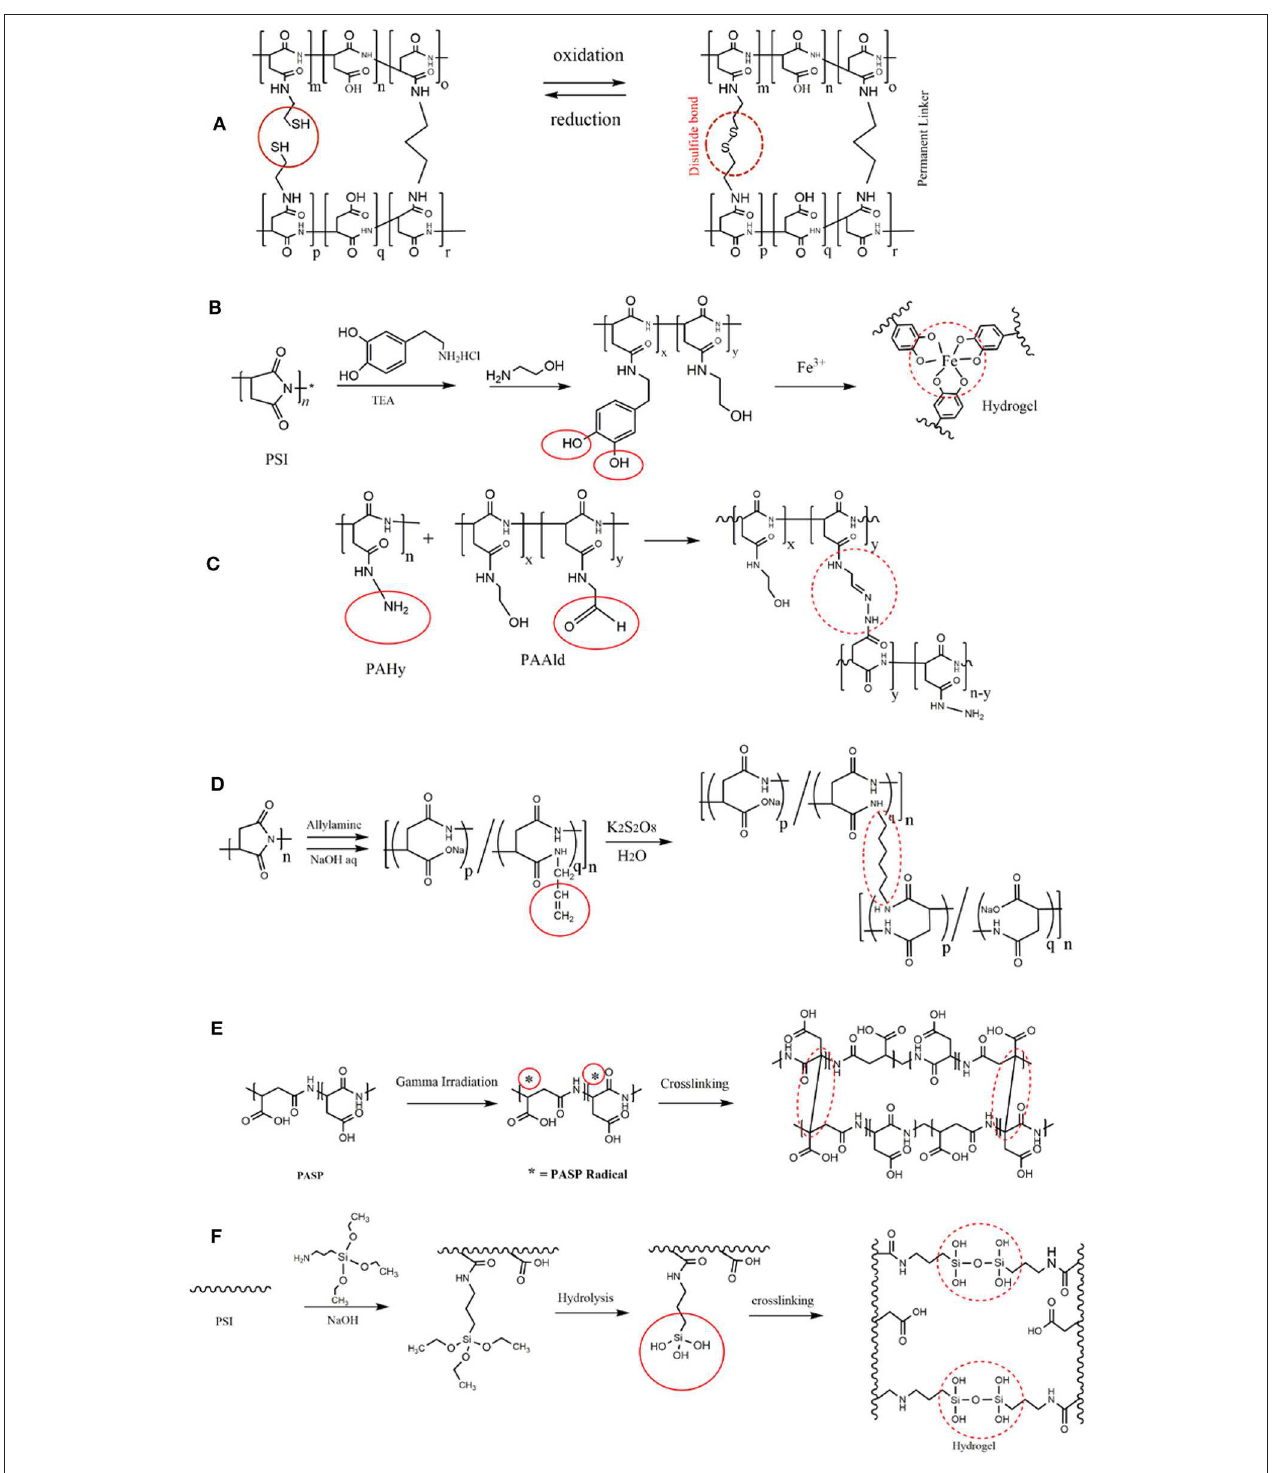
FIGURE 3 | PASP hydrogels prepared by different cross-linkers. (A) PASP hydrogel with a permanent and a cleavable cysteamine cross-linker exhibited response to oxidation/reduction without the gel dissolution. (B) Modification of PSI with dopamine led to PASP with catechol pendant groups which can establish complex with Fe 3 + ions, and form hydrogel as a results; adapted from Gong et al. (2017) with permission from Wiley. (C) Synthesis of injectable PASP hydrogels by introduction of aldehyde and amine groups on PASP. Reproduced from Lu et al. (2014) with permission from Wiley. (D) Allyl amine as a monomer that is polymerized via radical polymerization is grafted onto PASP; the subsequent polymerization of allyl amine gives rise to PASP-based hydrogel. (E) Application of gamma-irradiation for crosslinking of PASP. (F) Grafting of APTS as an aminosilane on PSI backbone followed by its hydrolysis.